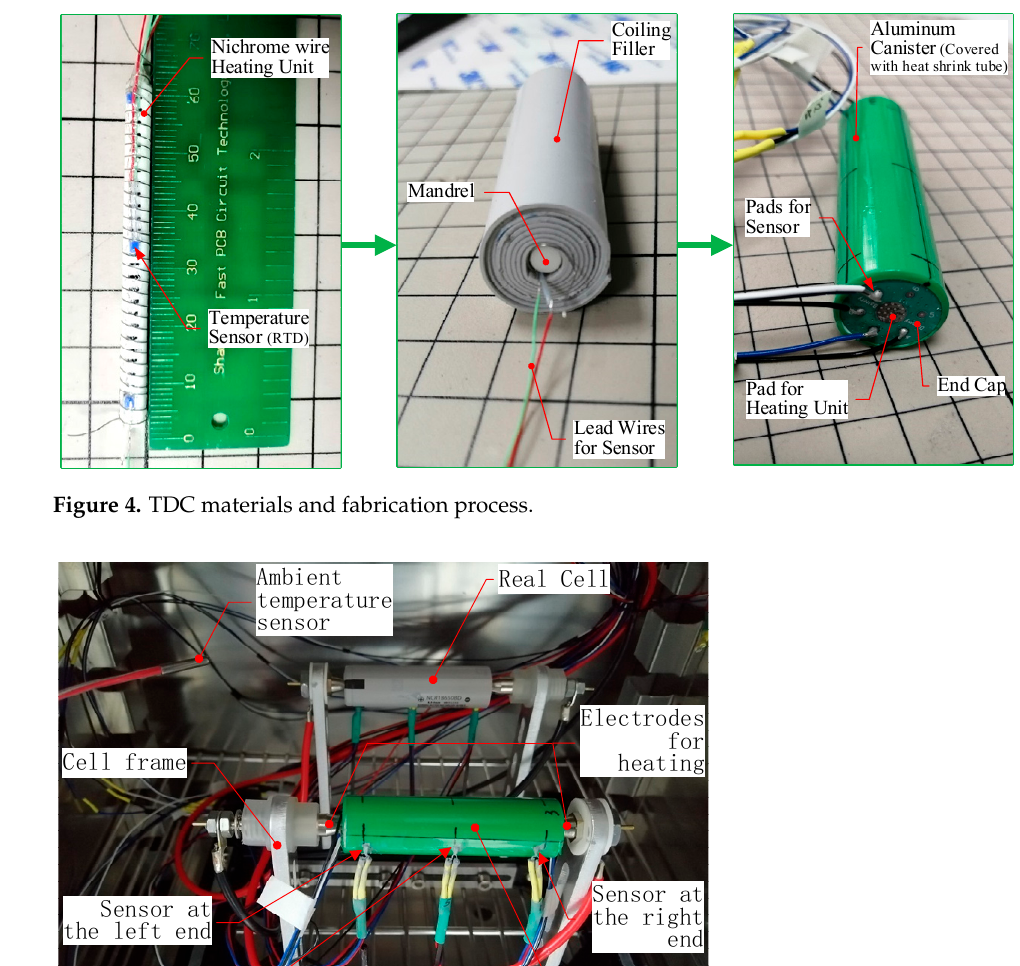
Figure 4. TDC materials and fabrication process.